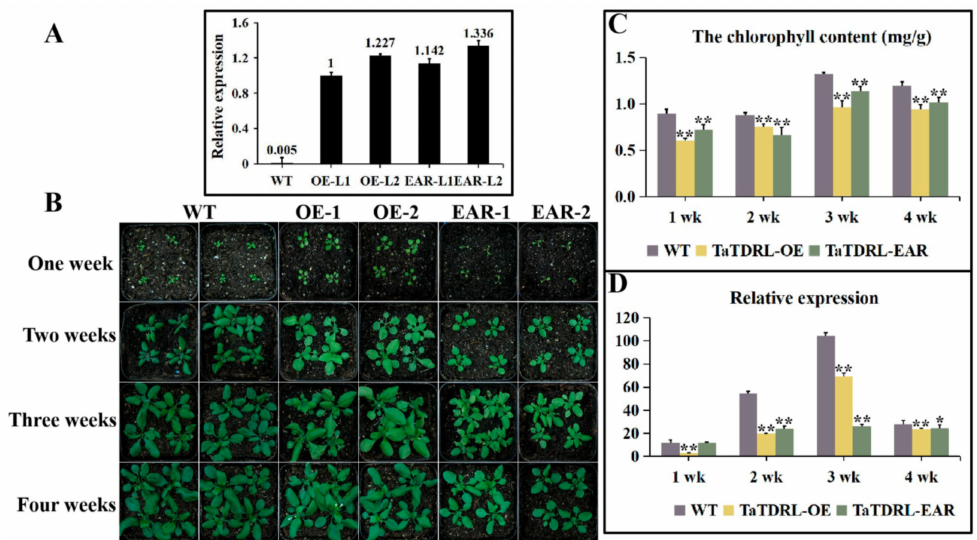
Figure 6. Phenotypic characterization of transgenic and wild-type (WT) Arabidopsis plants. ( A ) qRT-PCR identification of transgenic TaTDRL overexpression Arabidopsis plants. ( B ) Representative images show WT and transgenic lines, after one week of growth, two weeks of growth, three weeks of growth, and four weeks of growth. ( C ) Total content of chlorophyll in WT, TaTDRL-overexpressing (OE) and TaTDRL-EAR under normal conditions. ( D ) Expression of chlorophyll-responsive gene, AtPORC , in WT, TaTDRL-OE, and TaTDRL-EAR in response to chlorophyll biosynthesis. AtActin was used as an internal control. Data represent means ± SD ( n = 3). Each column represents the mean ± standard error based on three biological repeats. Significant di ff erences between WT and transgenic Arabidopsis lines were determined by Student’s test (* p ≤ 0.05, ** p ≤